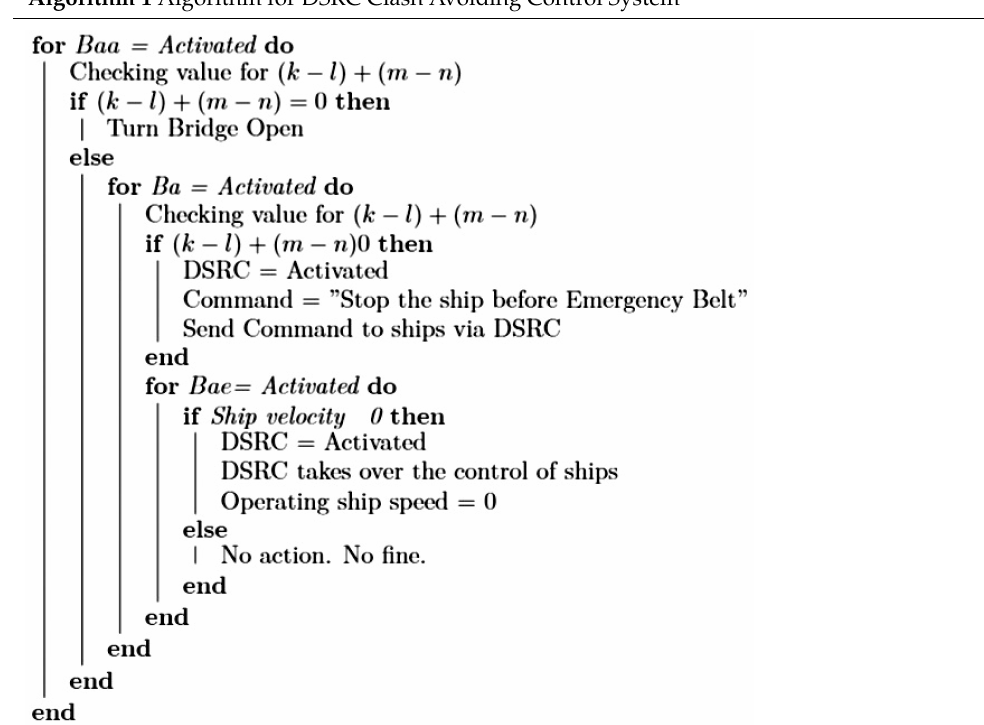
Algorithm 1 Algorithm for DSRC Clash Avoiding Control